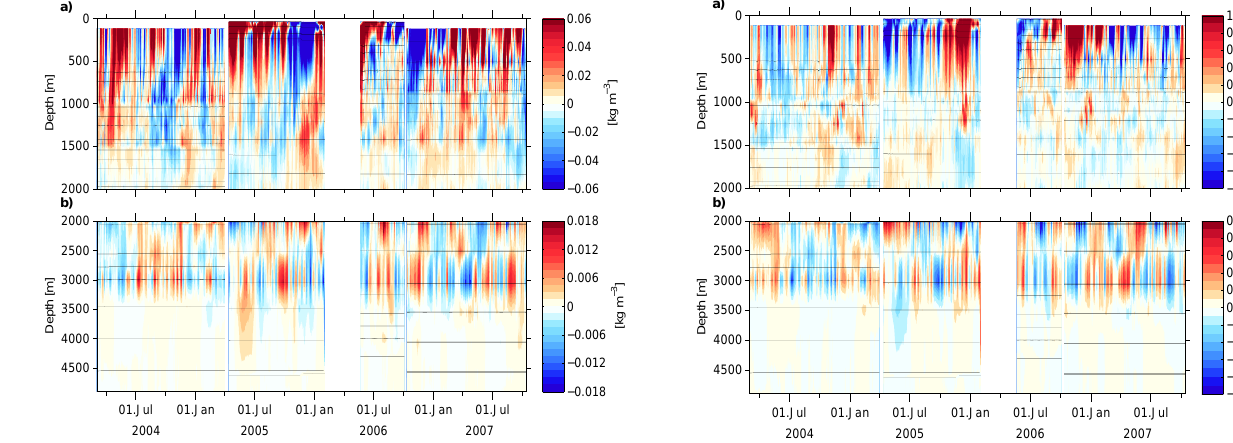
Fig. 6. 2-day low-pass filtered temperature anomaly at EBH, (a) from 0 to 2000m and (b) from 2000m to the bottom. Dates go from 4 March 2004 to 14 October 2007. For clarity, the anomalies computed around the time mean for each deployment period are shown. Note that panels (a) and (b) have different color scales. Horizontal lines are the levels of the measurements.